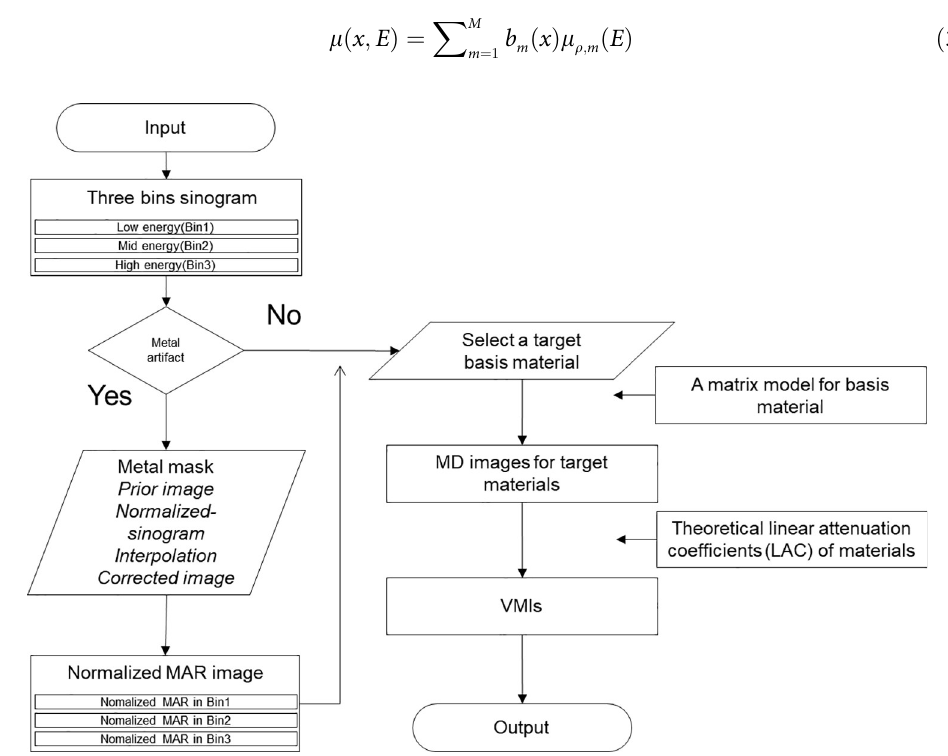
Fig 6. Scheme of metal artifact reduction and tissue characterization image for multi-energy CT. The NMAR method and MD are applied to the bin 1, bin 2, and bin 3 reconstructed images of different energy levels and created